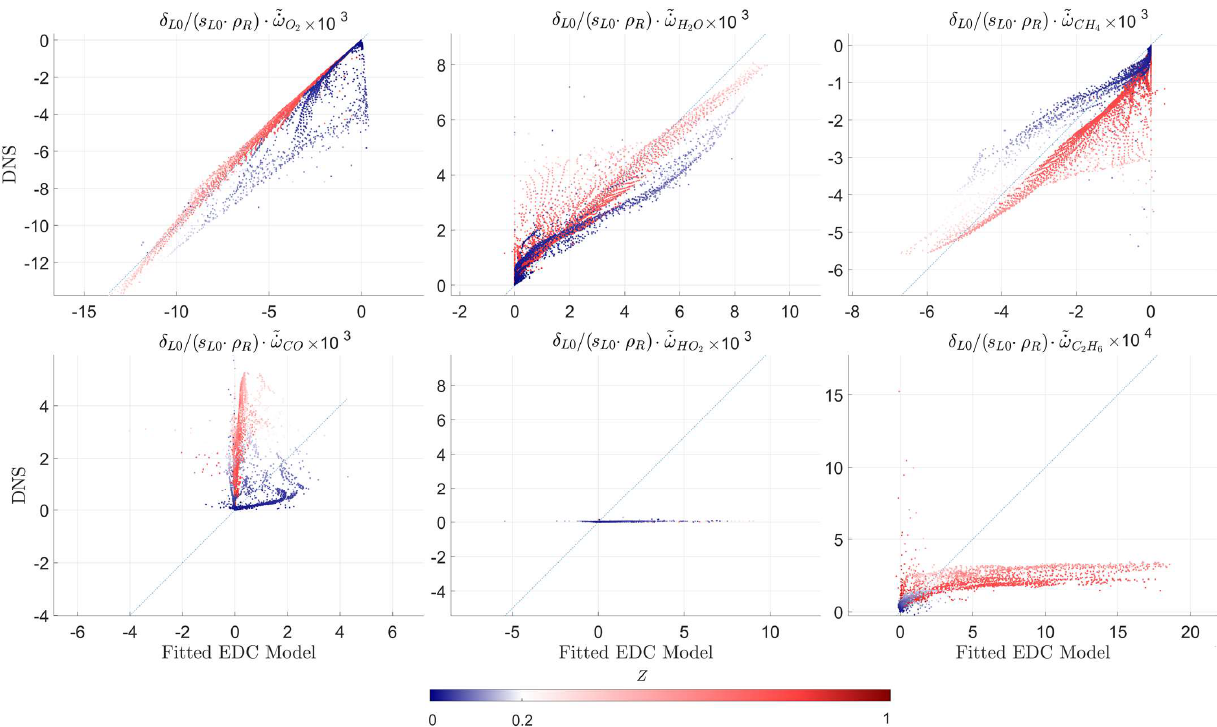
Figure 3. Example of prediction performance of the Eddy Dissipation Concept for different species and Re T > 70. This figure compares the observed average reaction rates with the EDC outcome.